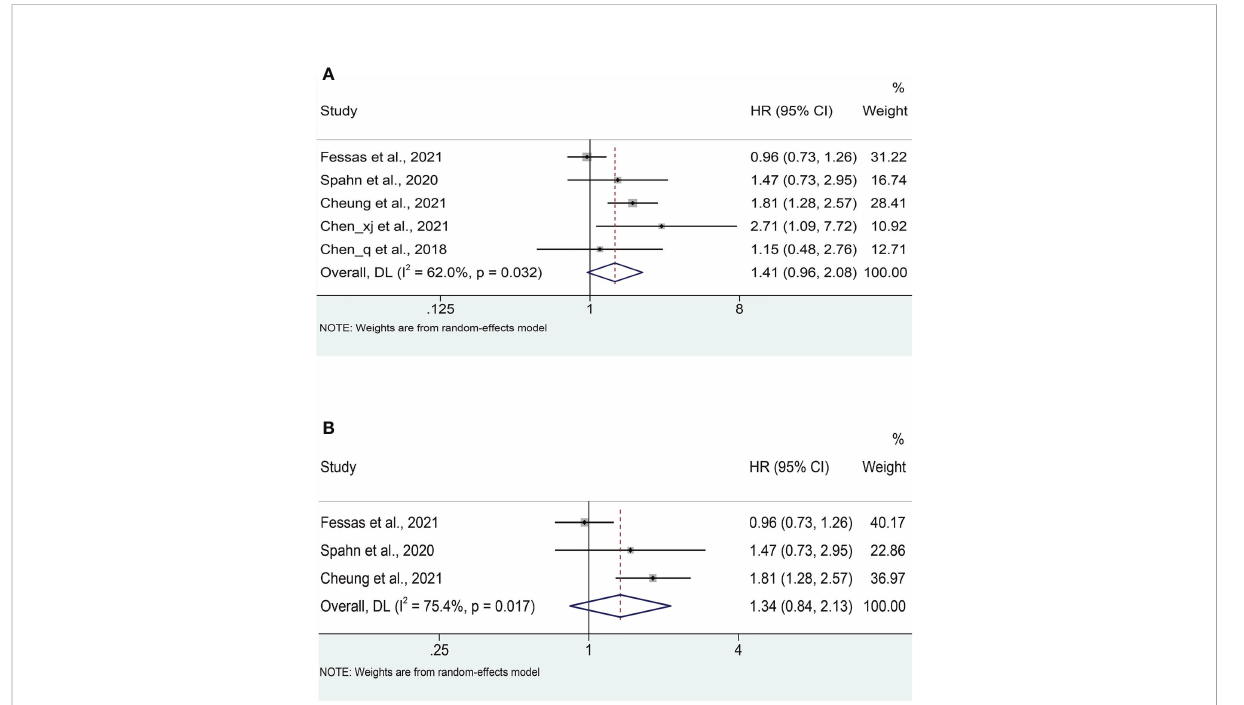
FIGURE 2 (A) Meta-analysisof theoverall OS. (B) Meta-analysisofOSafterexcludingChineseliterature.OS:overall survival;HR:hazardratio;CI:con fi